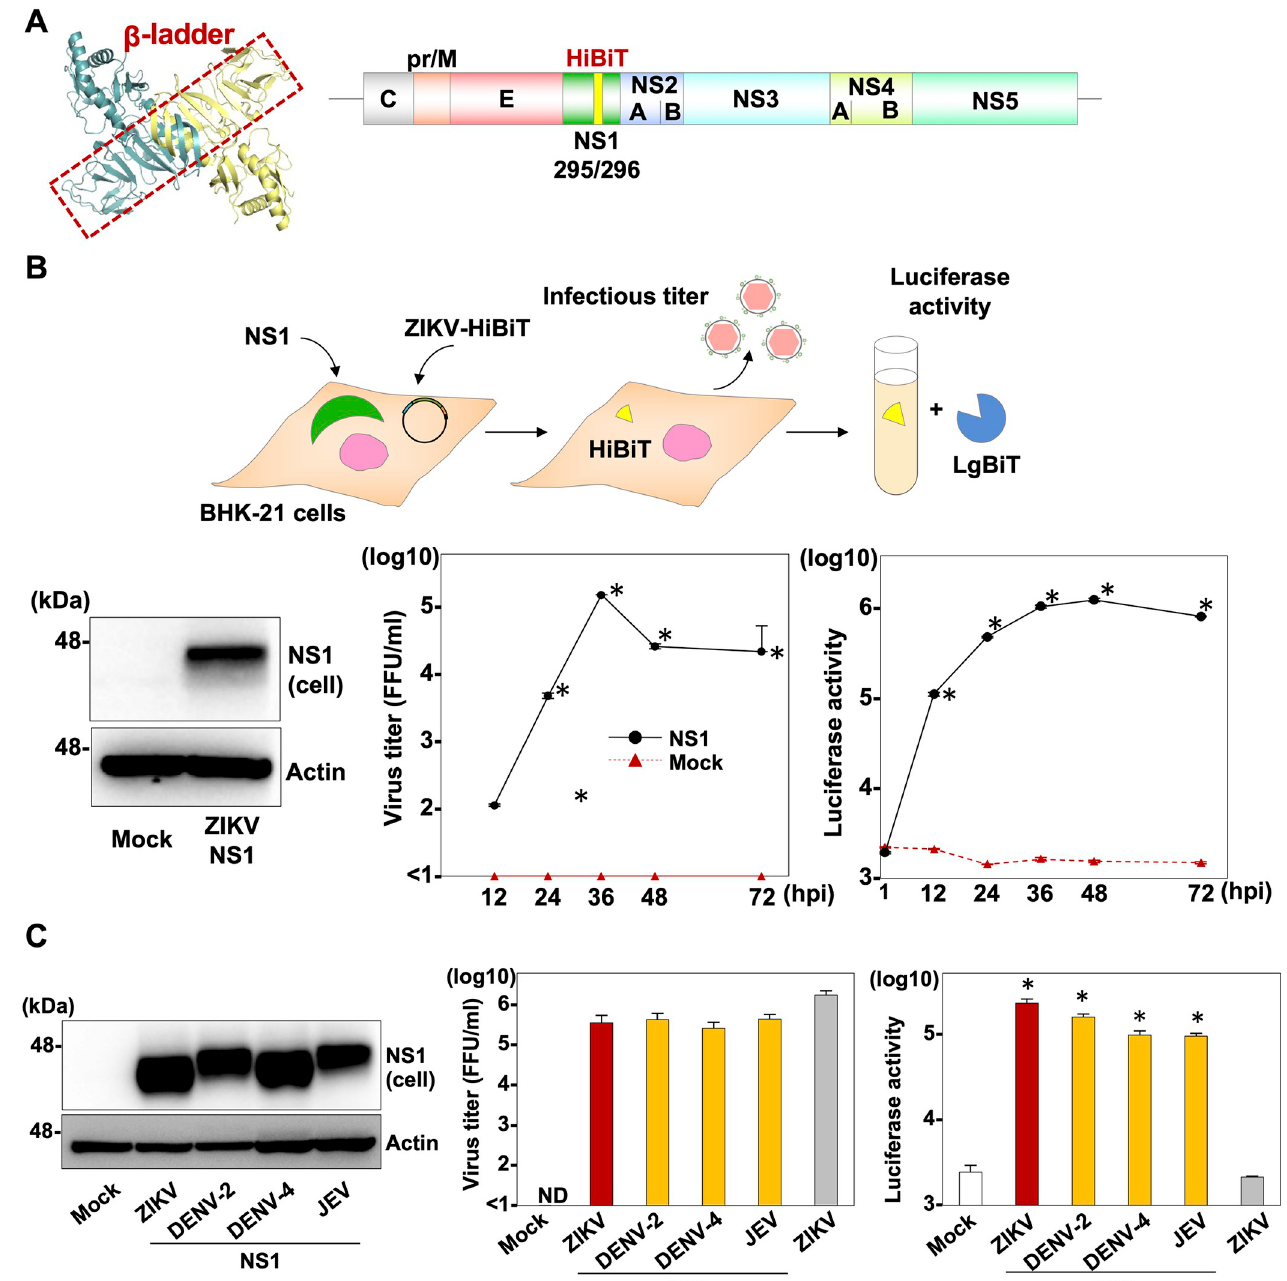
Fig 1. Generation of a reporter ZIKV that is unable to replicate but is rescued by the exogenous expression of NS1. (A) The HiBiT luciferase was inserted in the β -ladder of NS1 (NS1 dimer: Protein Data Bank accession number: 4TPL). A schematic representation of the recombinant ZIKV carrying the HiBiT luciferase in the NS1 gene (ZIKV-HiBiT). The HiBiT luciferase sequence with the GS linker was inserted at position 295 aa of NS1. (B) An illustration shows the experimental workflow. Expression of the ZIKV NS1 protein was determined by immunoblotting at 48 hpi of lentiviruses into BHK-21 cells. Luciferase activity in cells and infectious titers in the culture supernatants were determined upon infection of ZIKV-HiBiT at MOI = 0.1 into either parental cells (Mock) or cells expressing ZIKV NS1 (NS1) at the indicated timepoints. (C) NS1 proteins from ZIKV, DENV-2, DENV-4, and JEV were expressed in BHK-21 cells. Luciferase activities in the cells and infectious titers in the culture supernatants were determined at 36 hpt of ZIKV-HiBiT into cells expressing these NS1proteins. Statistical significance was assessed using Student’s t -test (B) or one-way ANOVA with Dunnett’s test (C) and is indicated by asterisks ( � ) (versus control